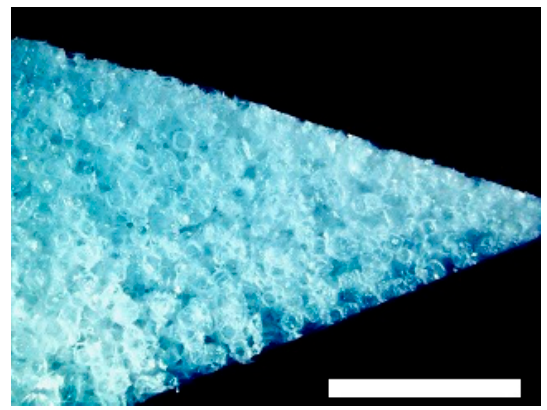
Figure 1. Macroscopic enhanced image of a hyaluronic acid gelatin composite scaffold. Scale bar = 1 mm.